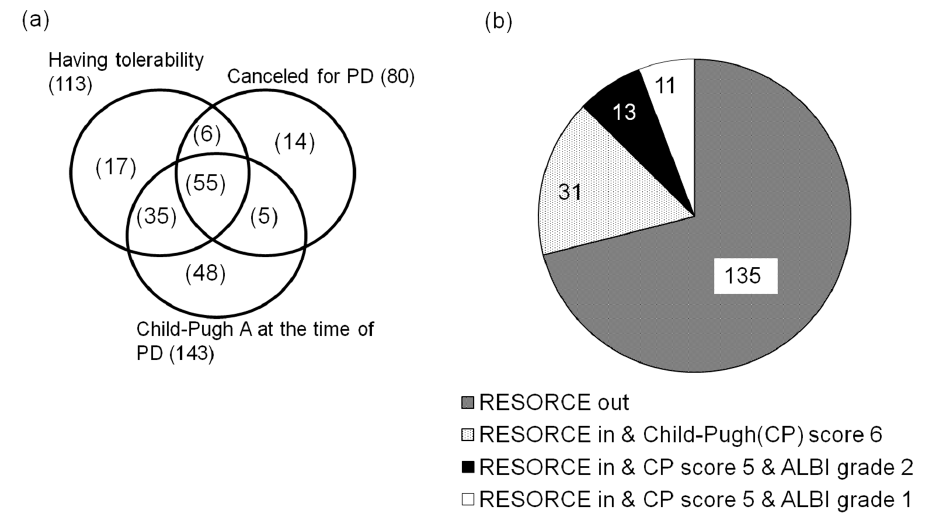
Figure 2. Proportion of patients fulfilling the criteria to be a good candidate for second-line treatment. ( a ) Proportion of patients in each RESORCE criteria. ( b ) Patients within Child–Pugh score 5 and within ALBI grade 1.